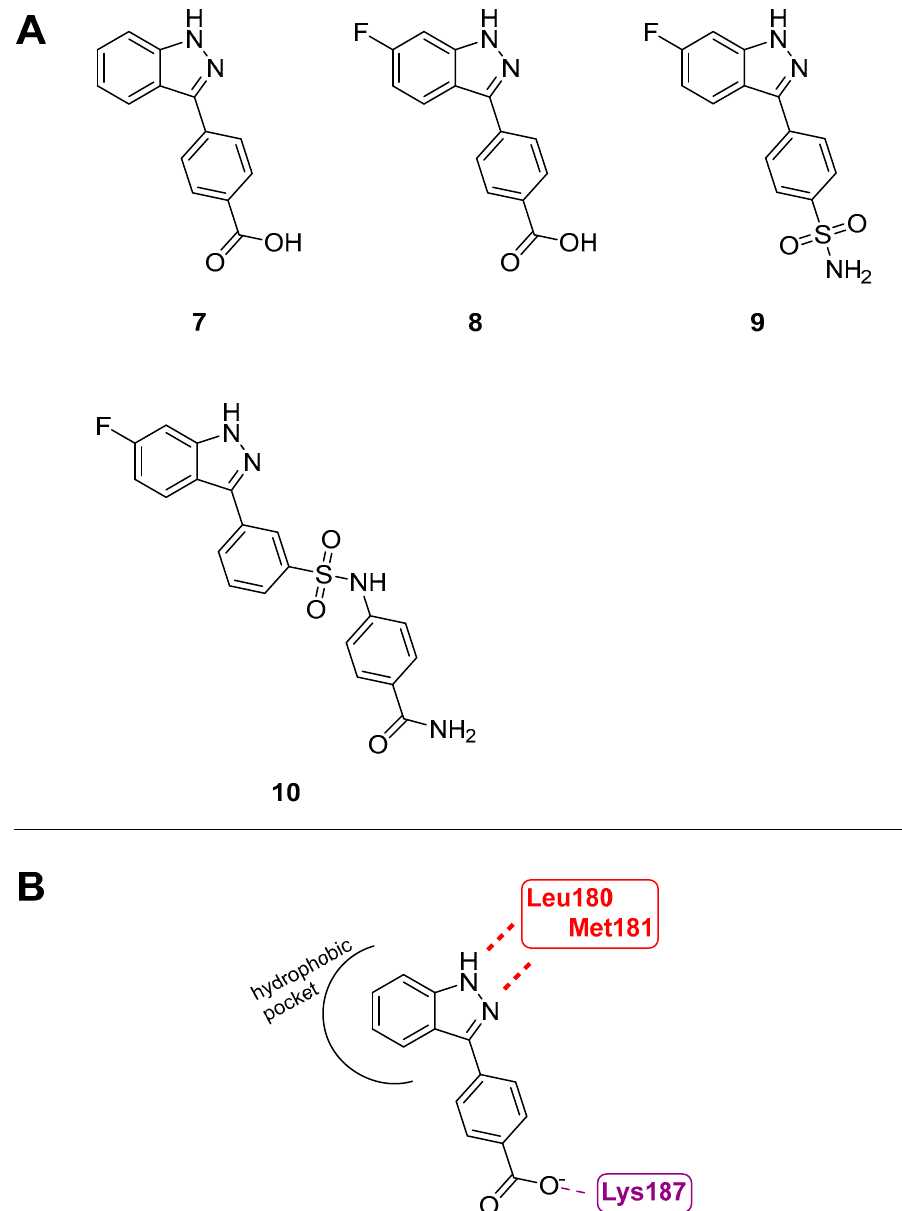
Figure 7. ( A ): 3-Arylindazoles; ( B ): predicted binding pose of 7 in MKK4 (3aln) according to Deibler et al. [25].